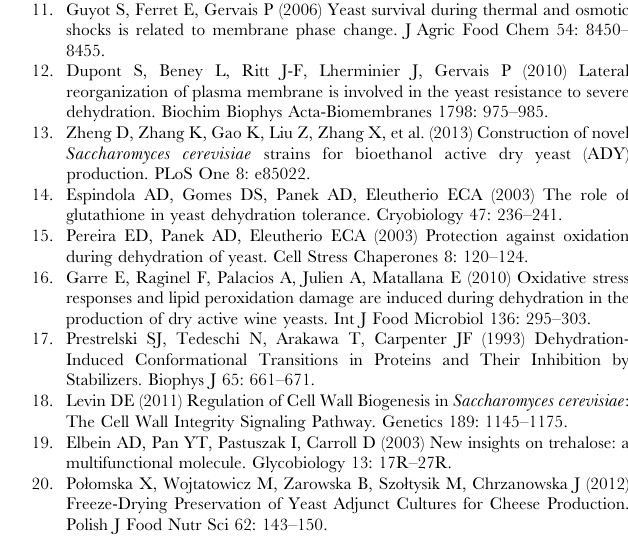
Figure S1 Example of flow cytometry raw data. Case of dried/rehydrated cells harvested in the stationary phase and suspended in trehalose solution. (A) Parameter check on unstained cells: FSC and SSC measurements define gating region R1, and cells autofluorescence is eliminated from regions RN1 (green fluorescence) and RN2 (red fluorescence) by adjusting gain parameters (as seen by the surrounding solid gray line). (B) Analysis of stained cells: all parameters defined in (A) are kept and compensation parameters (as seen by the surrounding dotted gray line) are introduced to correct the influence of red fluorescence on green fluorescence. All parameters seen by gray surroundings on (A) and (B) remain constant, regardless of the sample under analysis. For each analysis (B), the percentages of green-stained, dual-stained, red-stained and unstained cells are observed on the FL2= f (FL1) graph and the values are extracted from the table below the graph (as seen by the surrounding solid black line). These values are the ones used for statistical analysis and shown on Figure 3.